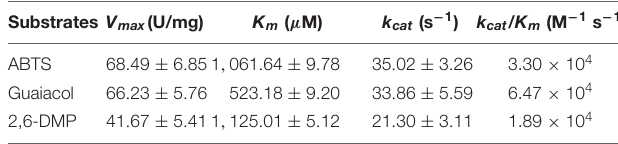
TABLE 1 | The kinetic parameters of recombinant OhLac. The data were presented as the mean ± SD (n =